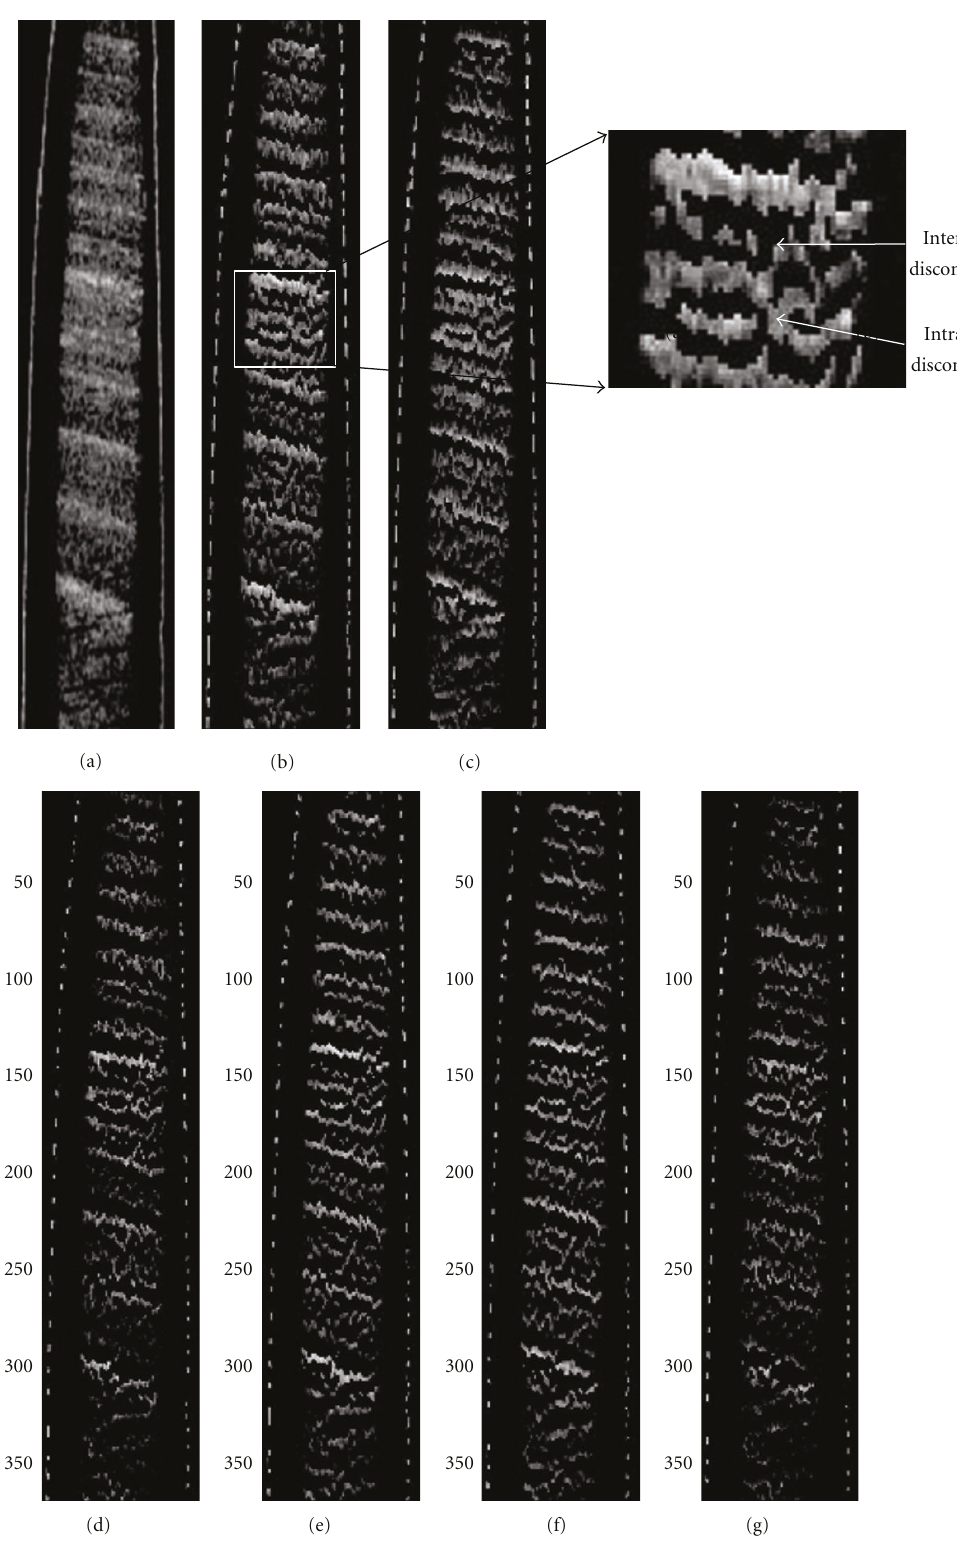
Figure 19: Tree growth estimates for populus sample graded “average” (variable frequency spacing): (a) original image, (b) first-half season, and (c) second-half season. Quarterly growth estimates: (d) 1st, (e) 2nd, (f) 3rd, and (g) 4th